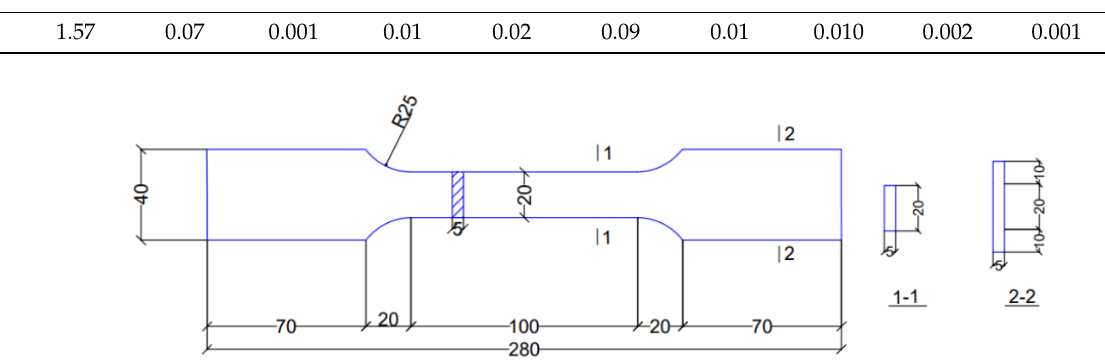
Figure 2. Dimensions of tensile coupon test specimen.